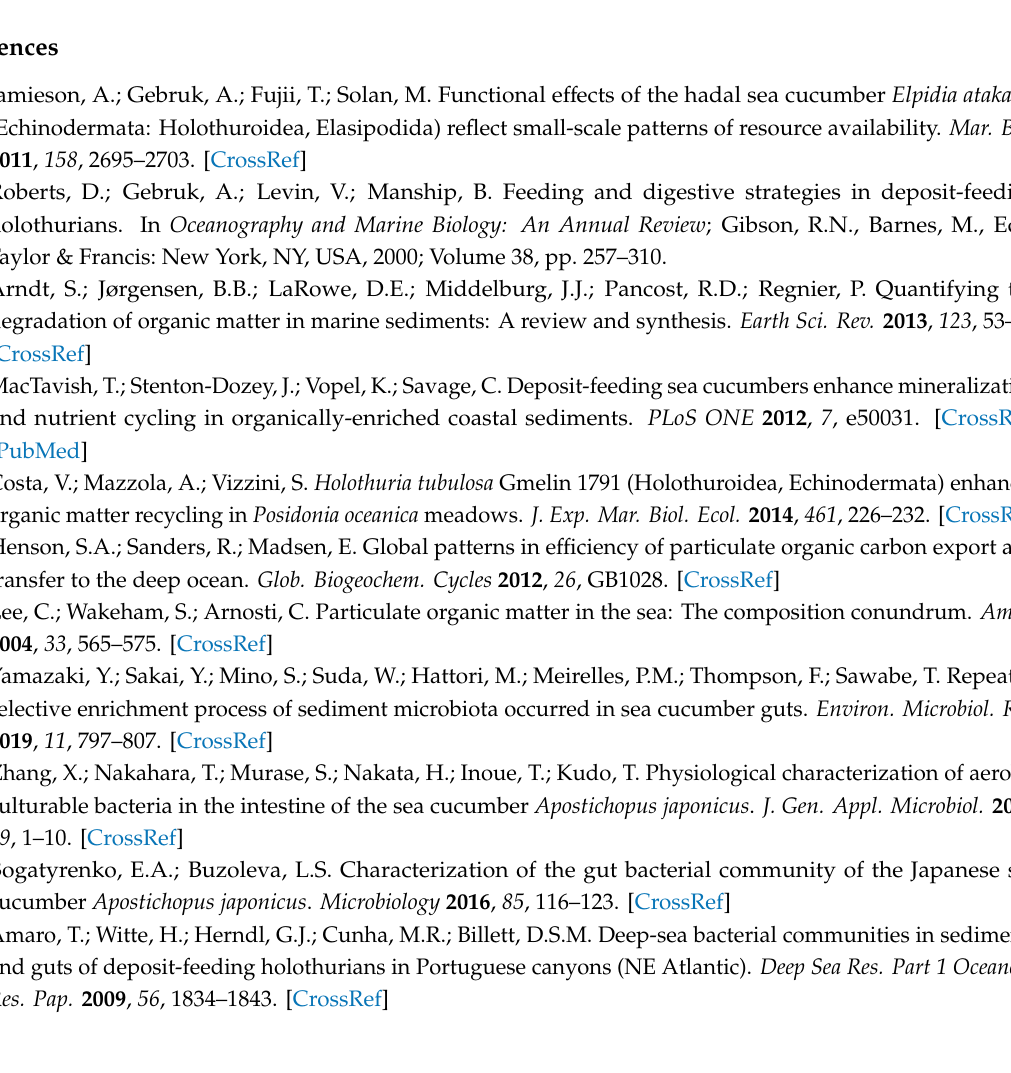
Figure S1: Photograph of (A) the sampling sites and (B) the intestine of M. musculus . The samples were collected from the Bay of Plenty (BP) of New Zealand. Figure S2: Gut microbial composition in (A) the intestines and (B) its content of M. musculus displayed at the genus level. BP1 and BP2 indicate two sampling sites in the Bay of Plenty. There are three individuals for each site. The hindgut of the BP2-3 sample failed to amplify the 16S rRNA gene fragments. The phyla in the classification are abbreviated by the first three letters. Genus with relative abundance < 1% is categorized into minor groups. Figure S3: Venn diagram of orthologous groups among Ca. Bathyoplasma sp. NZ, Haloplasma contractile , and four Ca. Izemoplasma bacteria. The numbers in parenthesis indicate the number and percentage of proteins clustered in orthologous groups for each species. Table S1: Information of sampling sites. Table S2: Summary of 16S rRNA amplicon reads. Table S3: Predicted proteins associated with restriction–modification